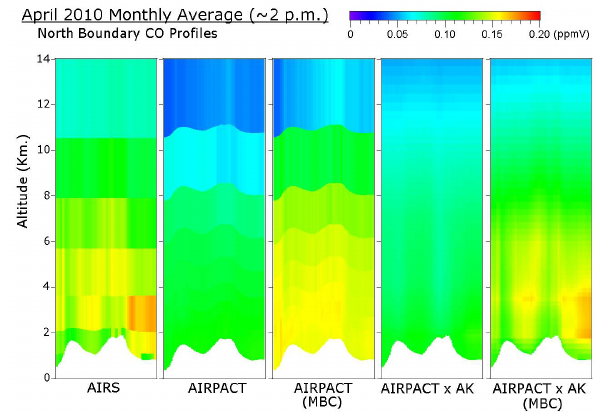
Fig. 11. April 2010 monthly average ( ∼ 02:00 p.m. PST) carbon monoxide profiles along the north border of AIRPACT-3 for (a) AIRS level-2 v5, (b) original AIRPACT-3, (c) AIRPACT-3 MBC, (d) original AIRPACT-3 convolved with the AIRS averaging kernel, and (e) AIRPACT-3 MBC convolved with the AIRS averaging ker- nel. Note that AIRPACT-3 values shown are the predicted CMAQ concentrations, and not boundary conditions themselves. For refer- ence, x-axes run from west to east: Vancouver Island (left) across British Columbia to the Alberta/British Columbia border (right).